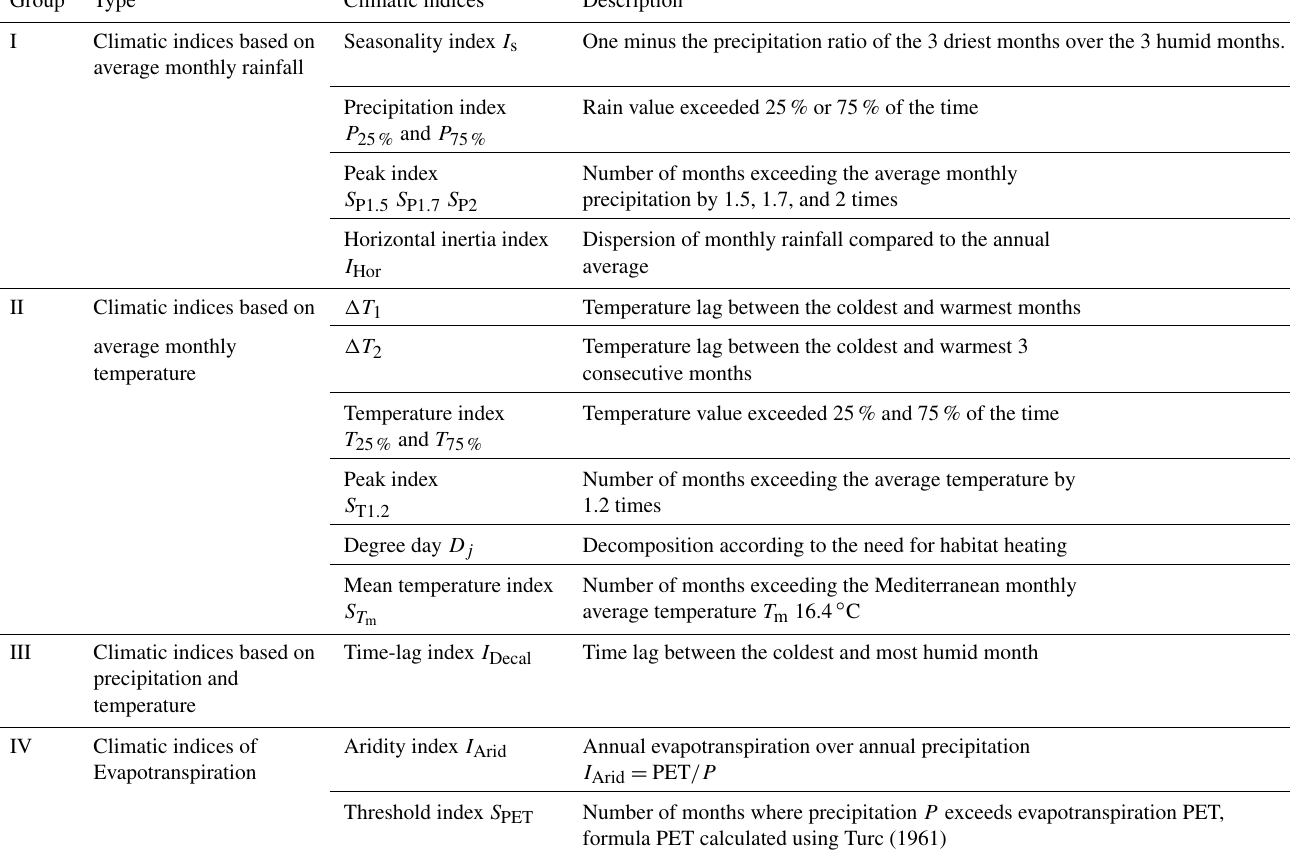
Table 3. Climatic indices